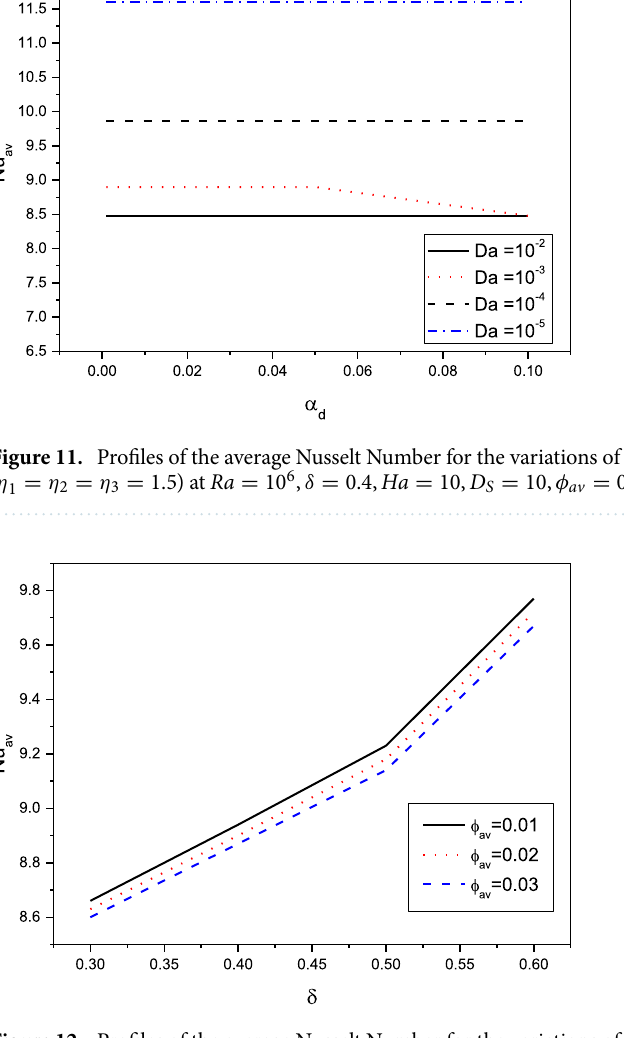
Figure 12. Profiles of the average Nusselt Number for the variations of δ and φ av in case of 1.5 ) at Ra (η 1 η 2 η 3 = = =